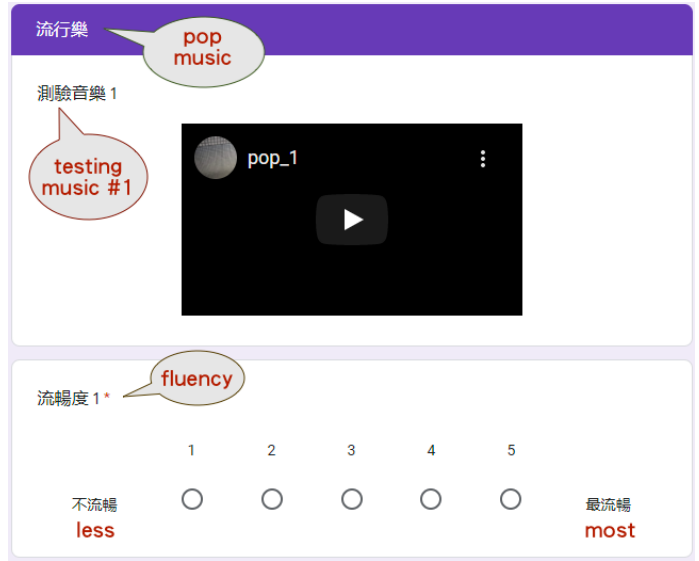
Figure 15. The screenshot of the listening test. (The text in the interface is in Chinese. We provide the English translation indicated with the box).